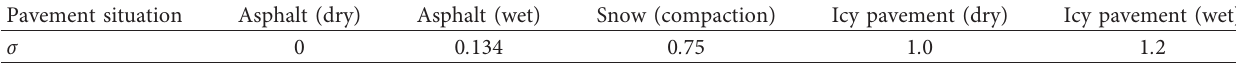
Table 3: Characteristic factor of common asphalt pavements σ